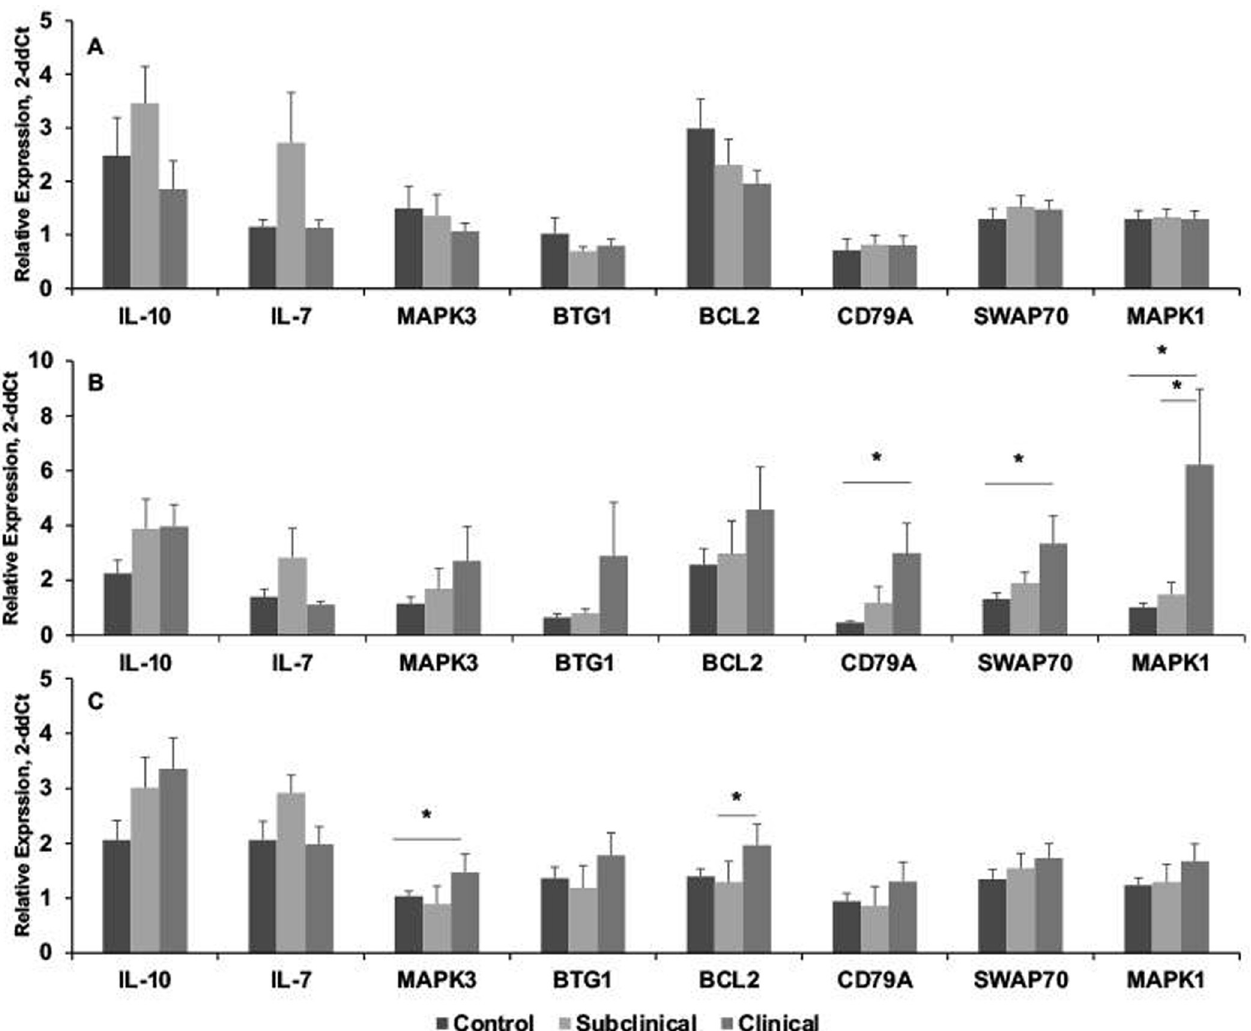
Fig 7. Relative gene expression (2 -ddCt ) for B cell markers and cytokines by PBMCs isolated from control noninfected cows and cows naturally infected with M . avium subsp. paratuberculosis . PBMCs were stimulated for 24 h in vitro with a whole cell sonicate (MPS; 10 μ g/ml) of M . avium subsp. paratuberculosis , RNA was extracted, and gene expression analyses were performed using Taqman Gene Expression Assays (Life Technologies, Grand Island, NY).